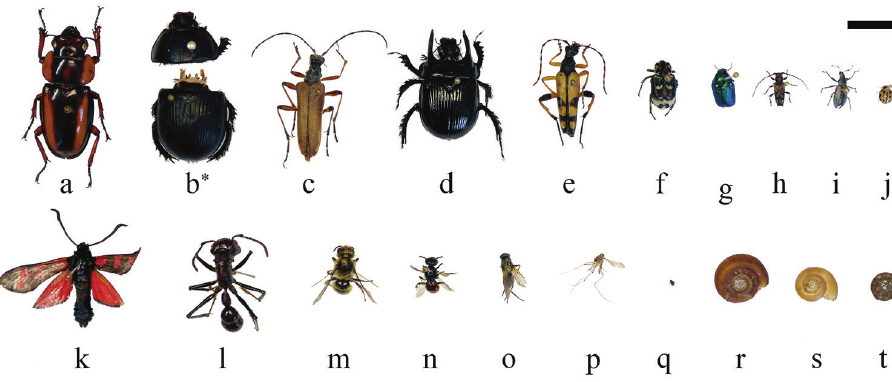
Figure 12. Overview and size comparison of the specimens used in this study. Coleoptera: a Proso- pocoilus savagei b Anoplotrupes stercorosus , *: specimen was broken during comparative measurements c Stenocorus meridianus d Typhaeus typhoeus e Rutpela maculata f Valgus hemipterus g Cryptocephalus sericeus h Pogonocherus hispidus i Phyllobius pyri j Tytthaspis sedecimpunctata ; Lepidoptera: k Zygae- na filipendulae ; Hymenoptera: l Paraponera clavata m Osmia adunca n Sphecodes ephippius ; Diptera: o Thricops sp., p Culex pipiens q Oscinella frit ; Gastropoda: r Helicodonta obvoluta s Aegopinella nitens t Discus rotundatus .; Scale bar: 1 cm (keep in mind that not all specimens are equidistant to the lens; i.e., at the same height of the needle).